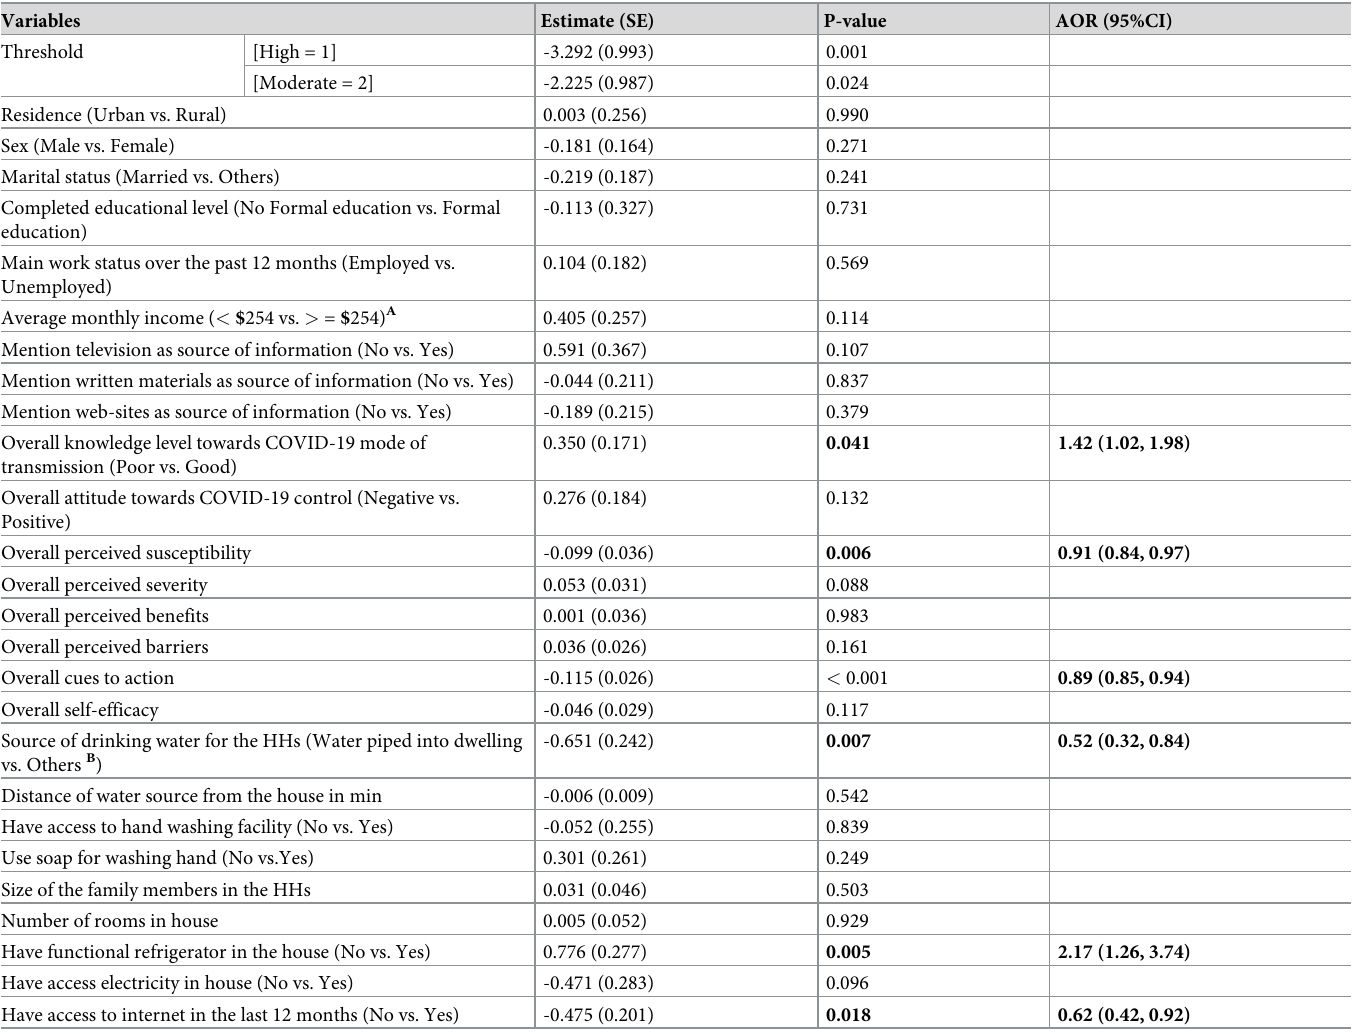
Table 5. Multivariable proportional odds model for predictors of compliance